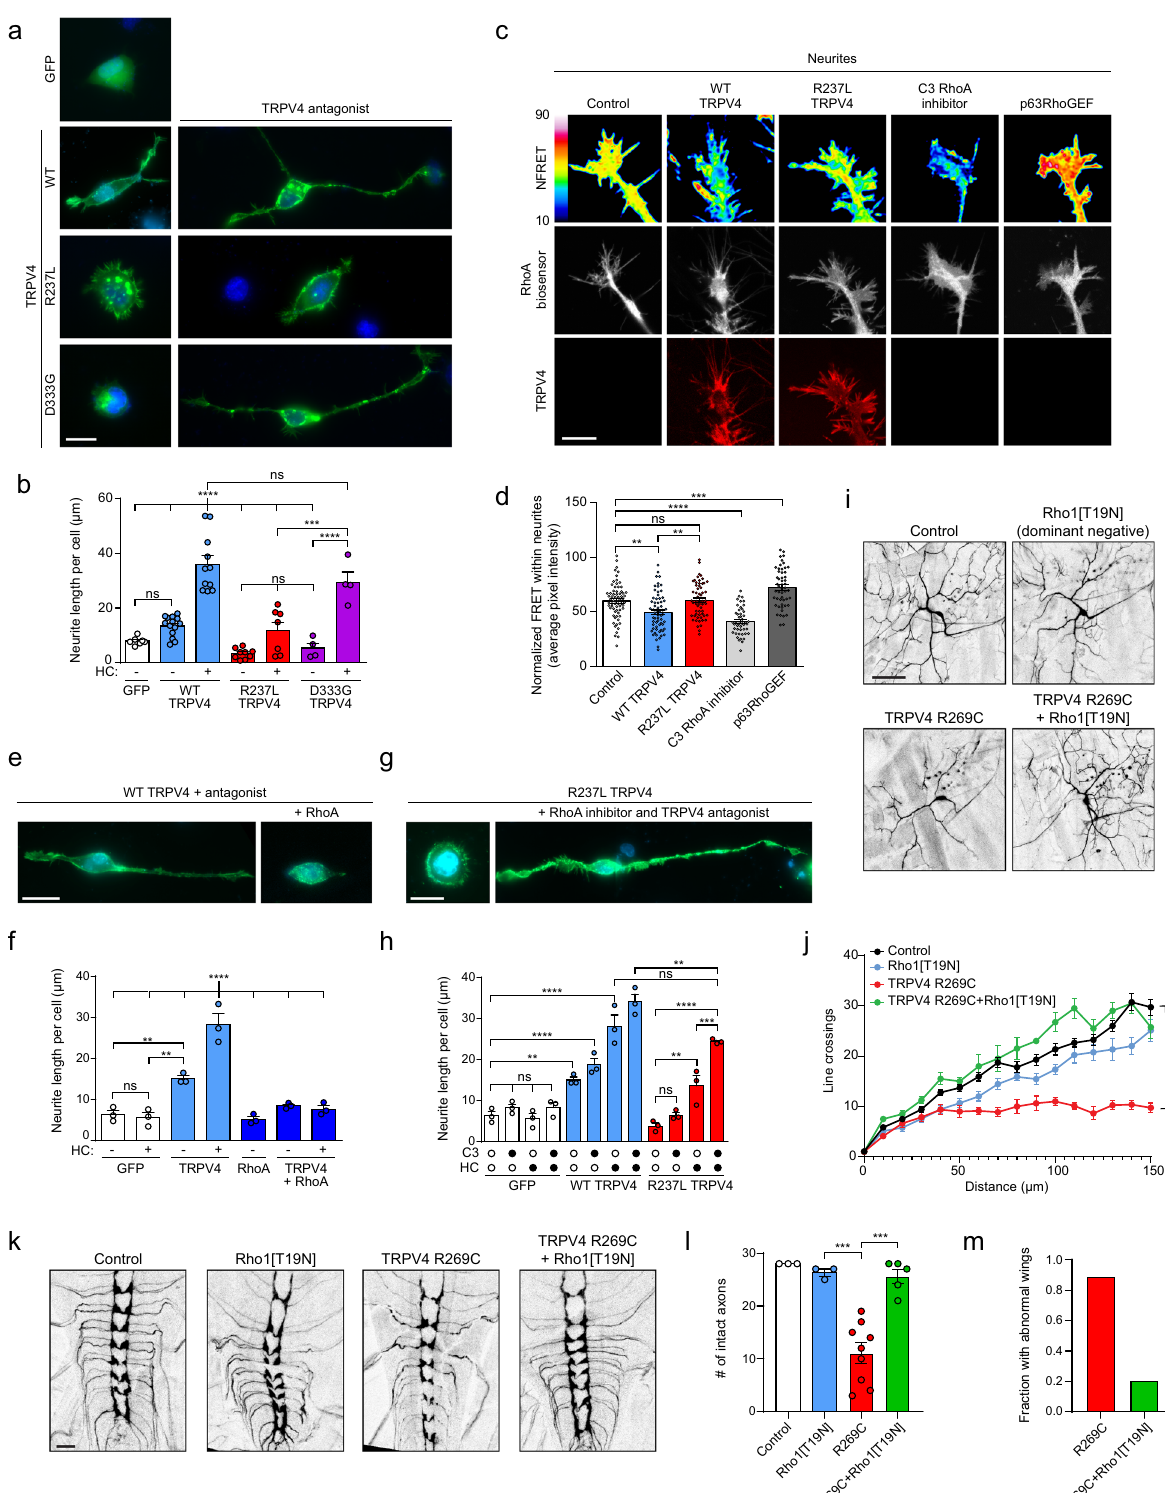
sensory neuron morphology and degeneration in the fl y model. results suggest that neuropathy mutant TRPV4 can cause Strikingly, we found that genetic inhibition of the activity of the cytoskeletal disruption in vivo through excessive activation of RhoA, and these defects can be rescued by RhoA inhibition. Drosophila RhoA ortholog Rho1 by expression of dominant negative Rho1[T19N] rescued both dendritic (Fig. 6i, j) and axonal (Fig. 6k, l) degeneration with expression of neuropathy mutant TRPV4. We also found strong rescue of wing opening failure with expression of Rho1[T19N] (Fig. 6m). Together, these NATURE COMMUNICATIONS| (2021) 12:1444